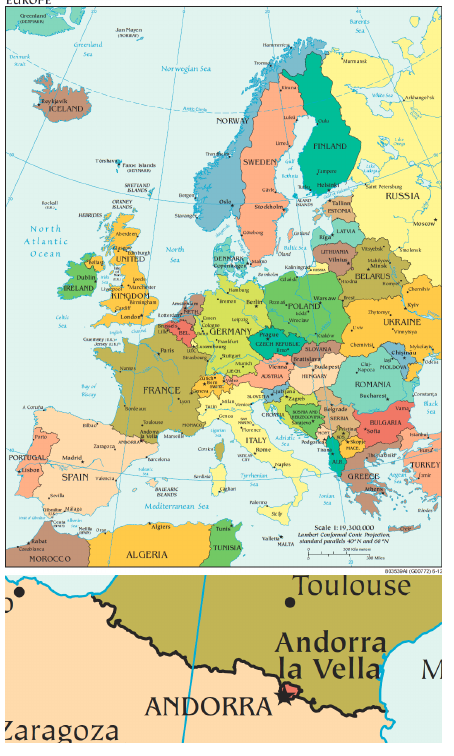
Figure 1: CIA, 2012, Europe